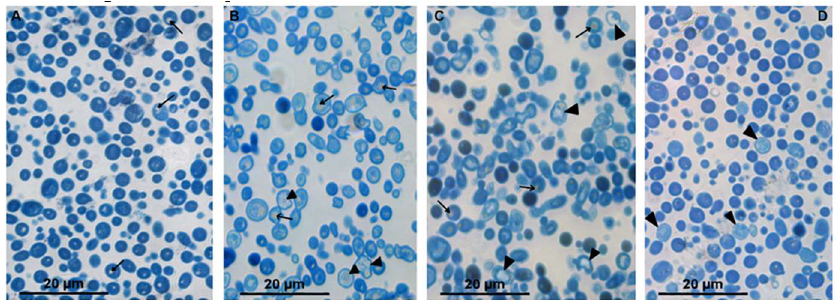
Figure 1. Semithin section of C. albicans suspensions stained with Azur II. ( A ) intact cells. Cells incubated for 4: ( B ) with (KFF)3K peptide; ( C ) with R9F2 peptide; and ( D ) with chlorhexidine. Arrows show lipid droplets; arrowheads–destroyed cells.